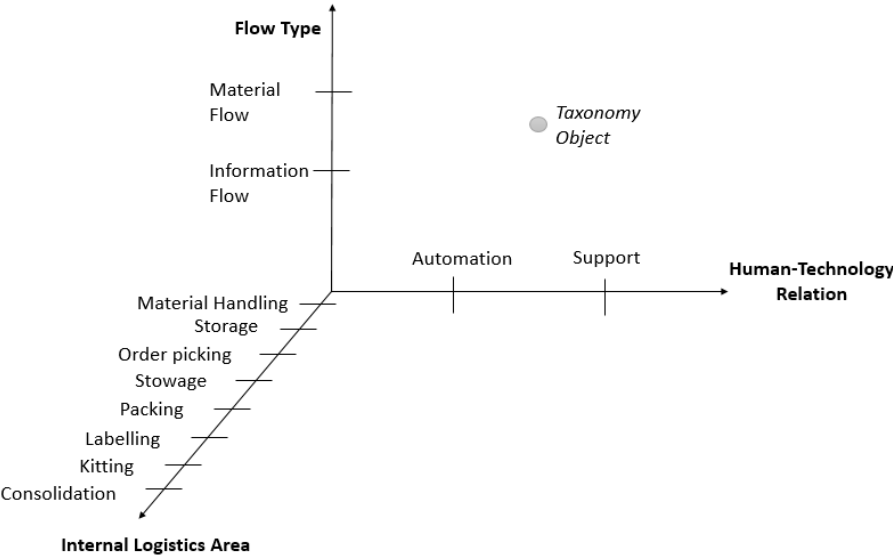
Figure 2. Taxonomy categories and dimensions.